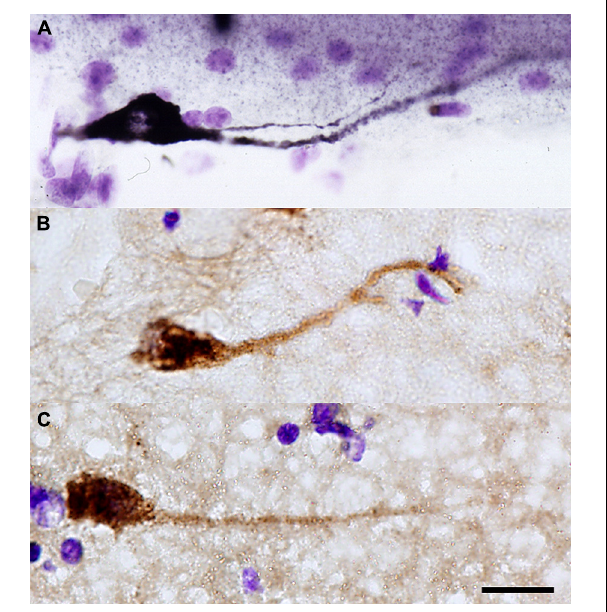
FIGURE 2 | Reln + horizontal cells in the temporal cortex of adult macaque (A) and human (B,C) . Scale bar: 10 μ